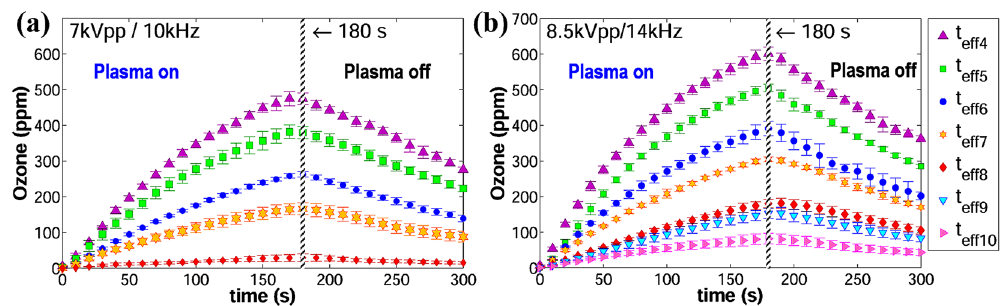
Figure 4. Curves of ozone vs. time corresponding to different values of t eff . ( a ) Voltage/frequency: 7 kVpp/10 kHz. ( b ) Voltage/frequency: 8.5 kVpp/14